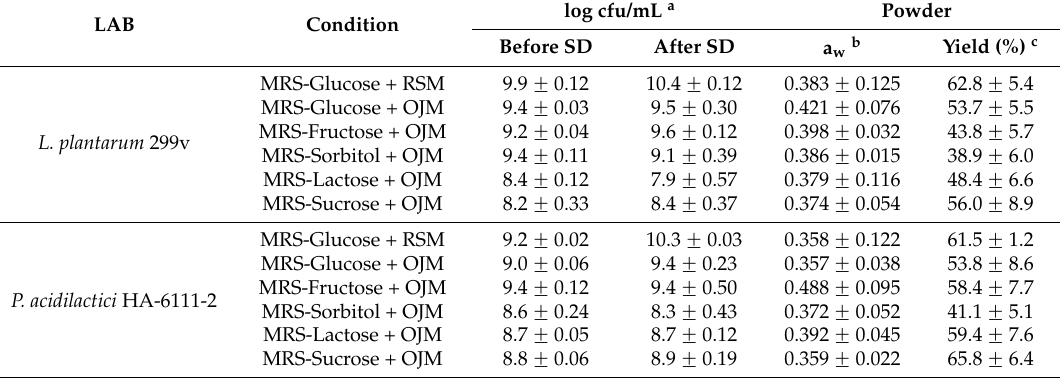
Table 1. Survival of LAB isolates before and after spray drying (SD) in RSM or in orange juice with 10 DE maltodextrin (OJM) after grown in standard or modified MRS and the a w values of and yield of the respective